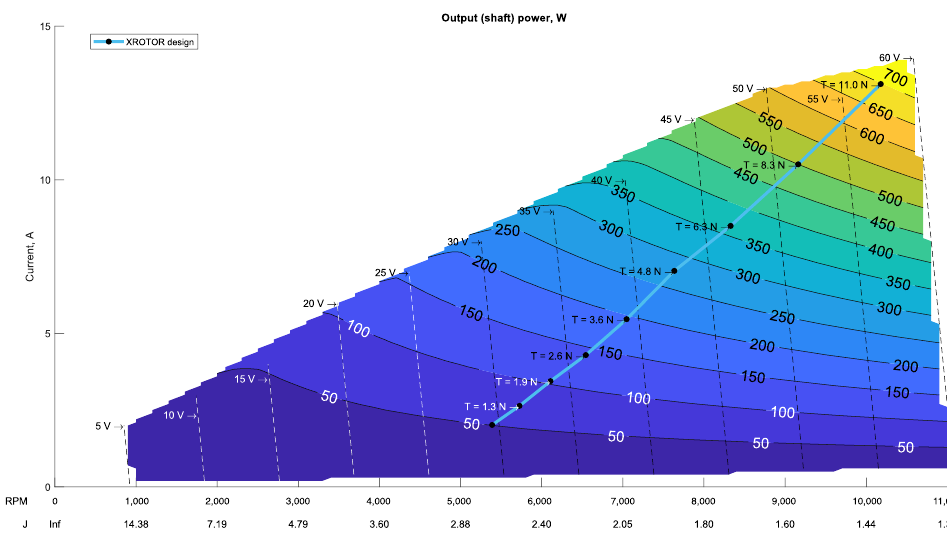
Figure 8. Lehner 2280/40 motor map: current vs. RPM, contour of motor power.